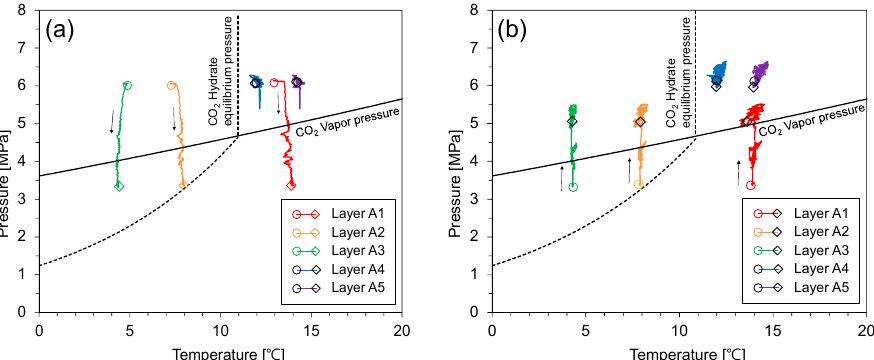
Figure 5. The pressure–temperature relationship during CO 2 injection. ( a ) 4680–8100 min, ( b ) 8100– 25,300 min.